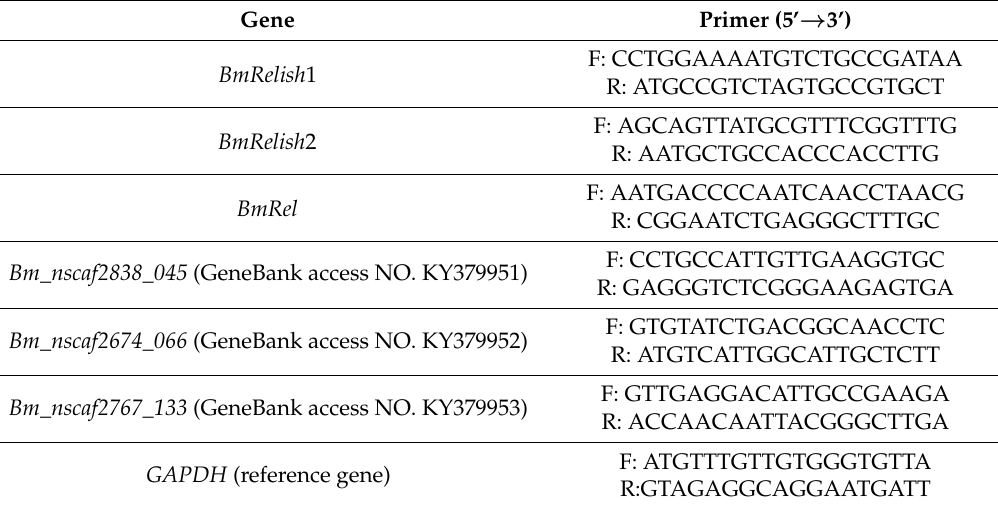
Table 2. Primers of the silkworm genes for qPCR